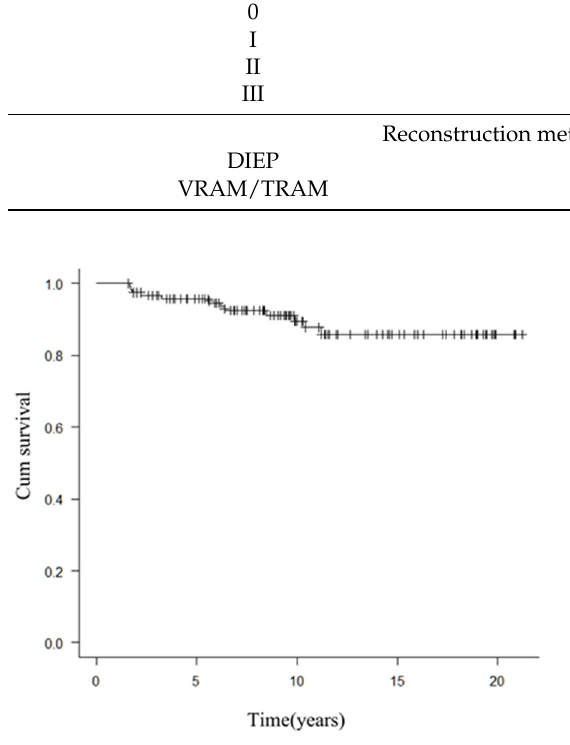
Figure 1. Overall survival of the 119 cases.